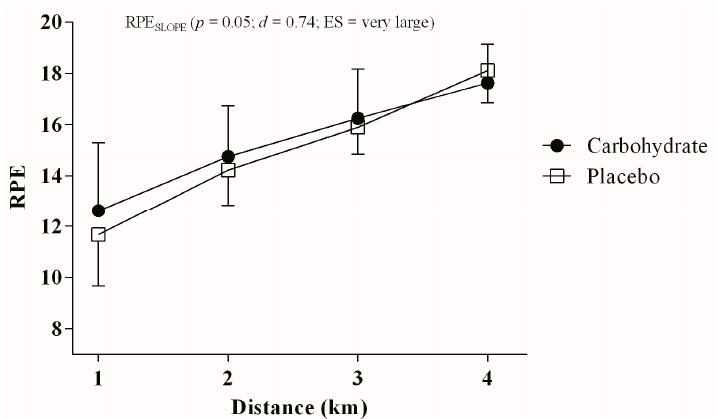
Figure 4. RPE responses measured each 1 km during the TT 4km in carbohydrate (filled circles) and placebo mouth rinse (open squares). placebo mouth rinse (open